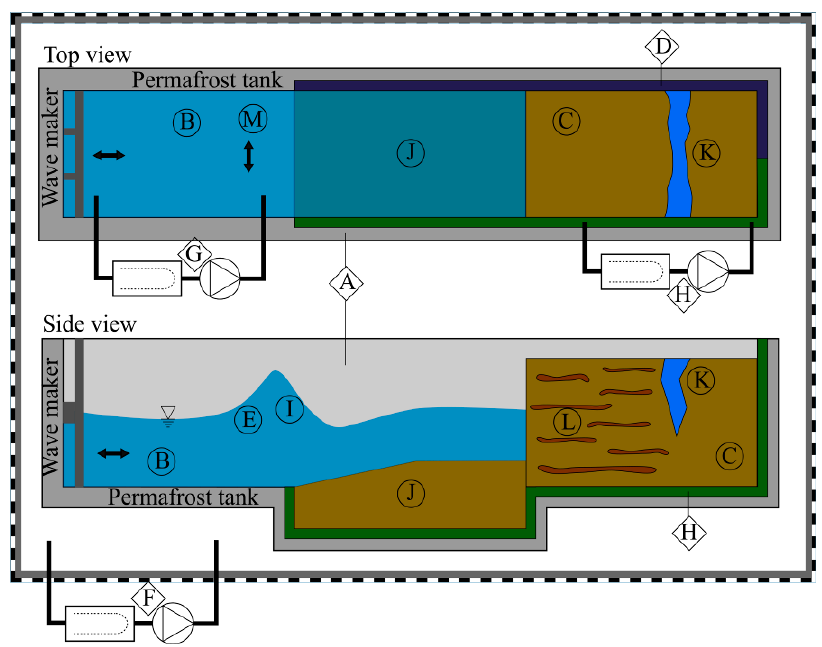
Figure 4. Framework design for investigating laboratory-based permafrost coastline erosion. Permafrost 3D-tank, with media/material indicated by circled symbols, and technical